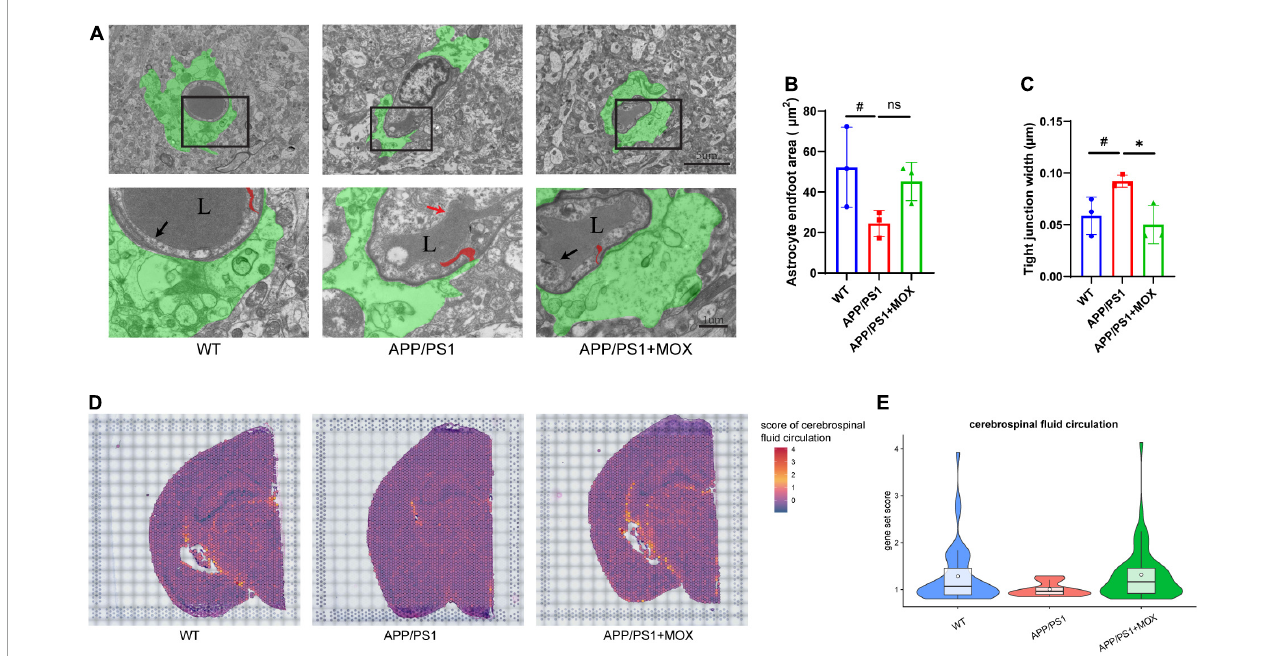
FIGURE4 The reduction of the astrocyte endfoot area and cerebrospinal fluid circulation level in APP/PS1 mice. (A) Transmission electron microscopy images of the BBB. Green areas indicate astrocyte endfoot; red areas indicate endothelial tight junctions; black arrows point to normal endothelial lining; red arrow point to damaged endothelial lining; L, vascular lumen. Scale bar, 5 µ m and 1 µ m. (B,C) Barplot of astrocyte endfoot area and tight junction width ( N = 3). (D) Brain maps of cerebrospinal fluid circulation level (GO:0090660). (E) Violin plots of cerebrospinal fluid circulation level (gene set score > 0.8). A one-way analysis of variance with post-test # P < 0.05, APP/PS1 vs. WT; ∗ P < 0.05, APP/PS1 + MOX vs.